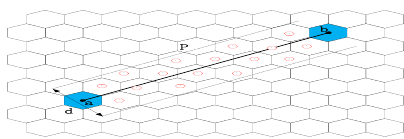
Figure 1. Schematic diagram of hexagon grid discrete line